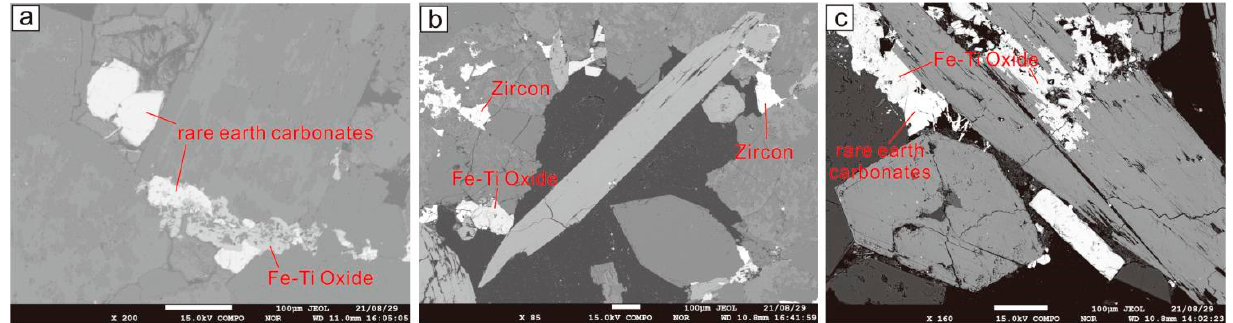
Figure 4. BSE of the accessory minerals in peralkaline miarolitic granite. ( a ) The rare earth carbonates and Fe-Ti Oxide in peralkaline microlitic granite; ( b ) Interstitial zircons in peralkaline microlitic granite; ( c ) the rare earth carbonates and Fe-Ti Oxide in peralkaline microlitic granite.